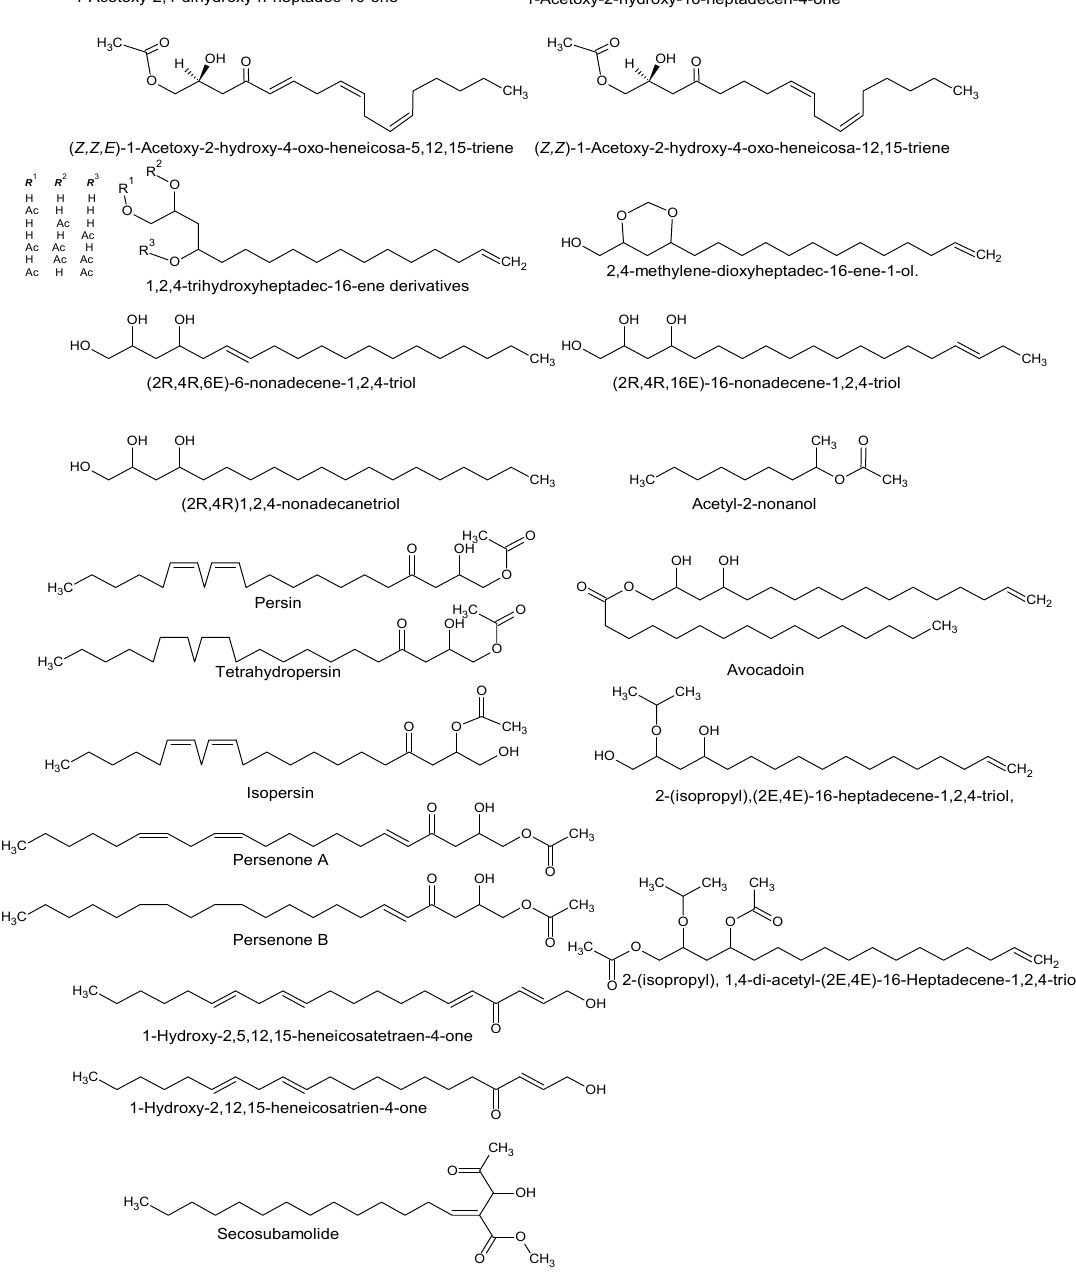
Figure 1. Fatty alcohols isolated from